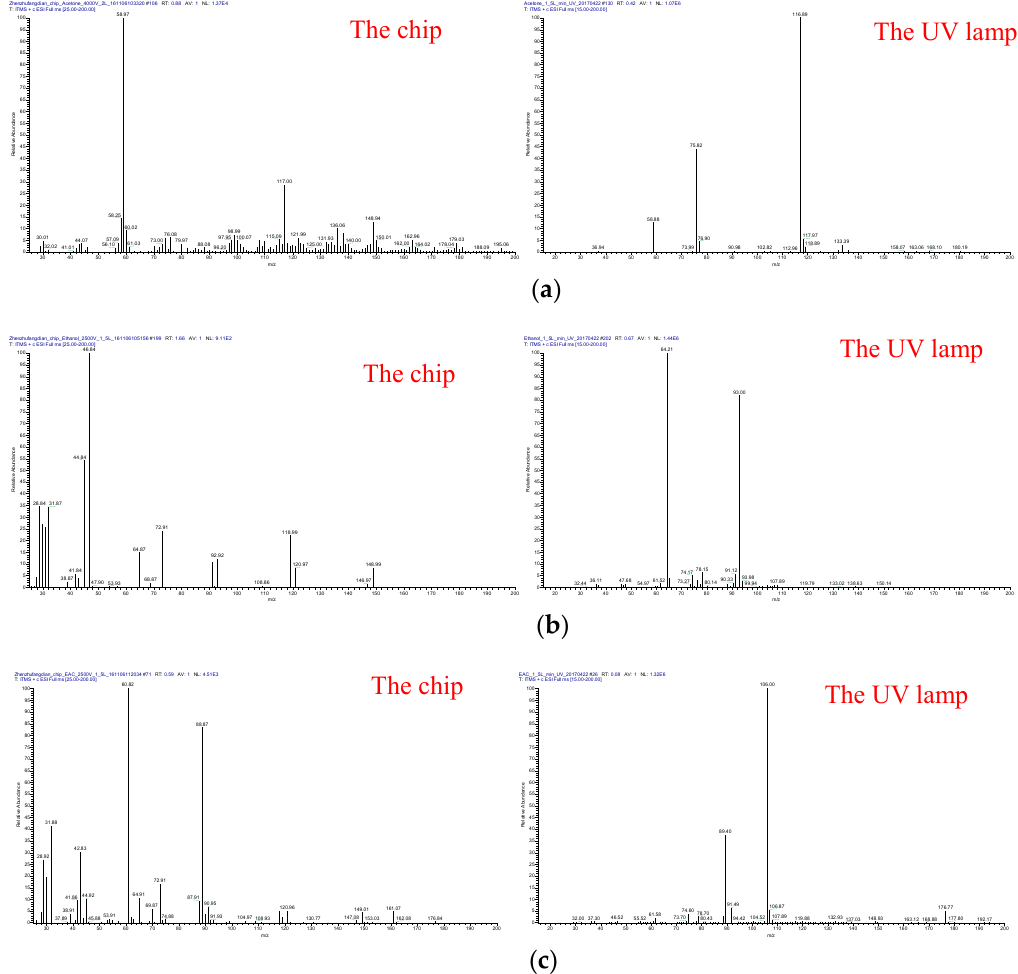
Figure 8. Comparison of mass spectra of ( a ) acetone ( b ) ethanol ( c ) acetic ether gas with the microelectromechanical systems (MEMS) chip and UV lamp ion source. Table 1. Ion species in mass spectra obtained by the needle-cylinder chip and UV